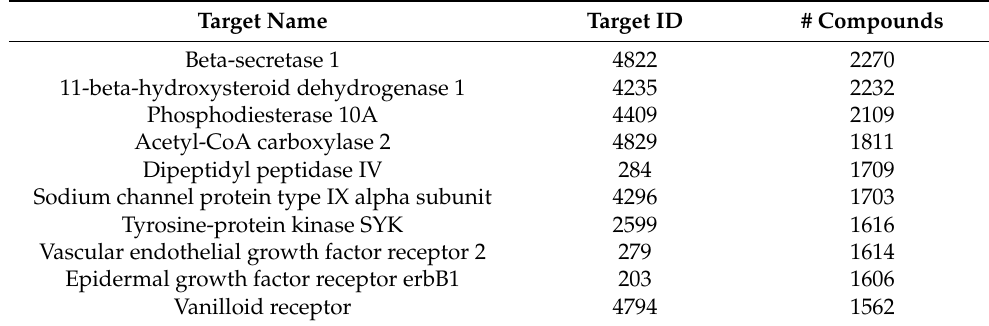
Table 1. Activity classes. Ten activity classes used for deriving and evaluating activity class-based prediction models are